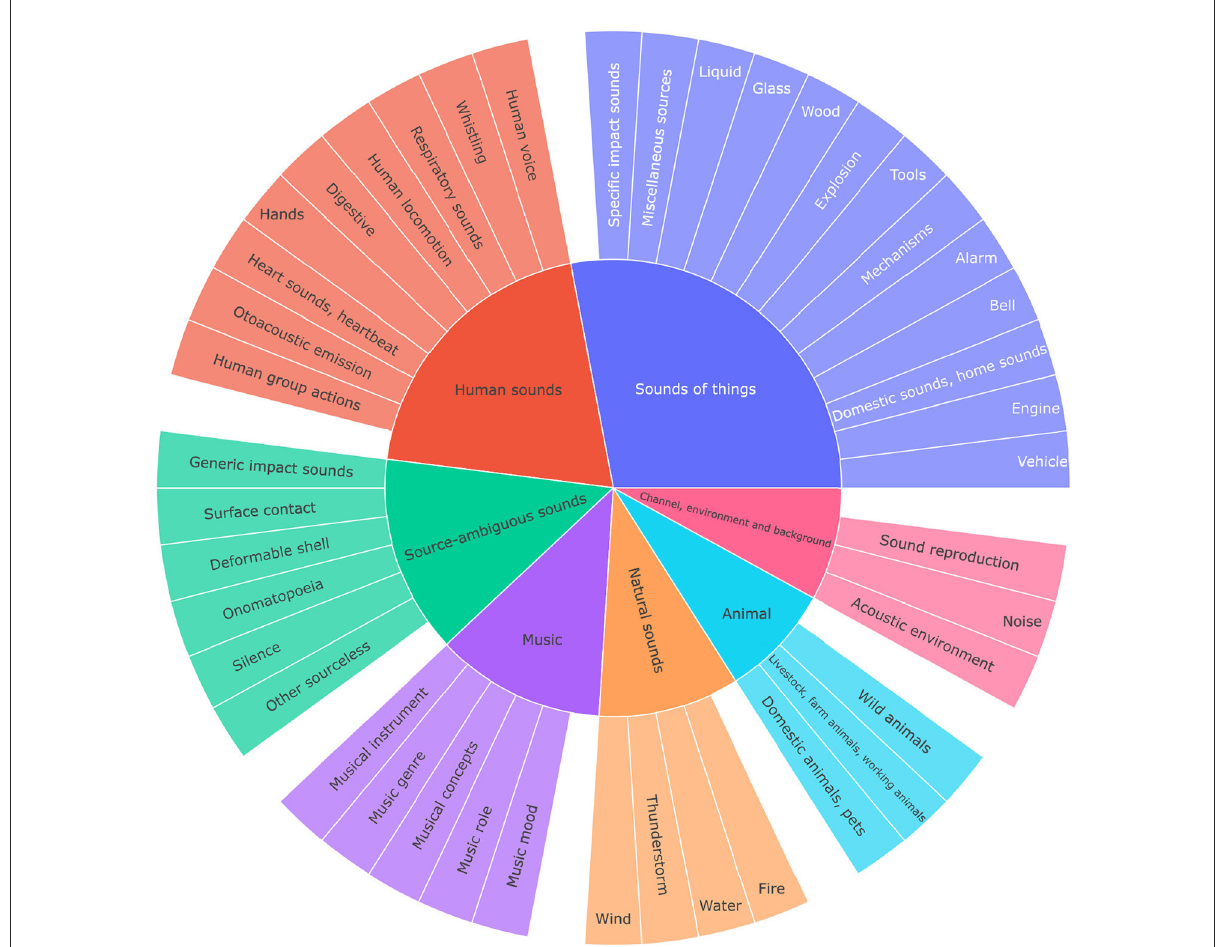
FIGURE8 Sunburst diagram representation of the top two levels of the Audioset taxonomy (Gemmeke et al.,